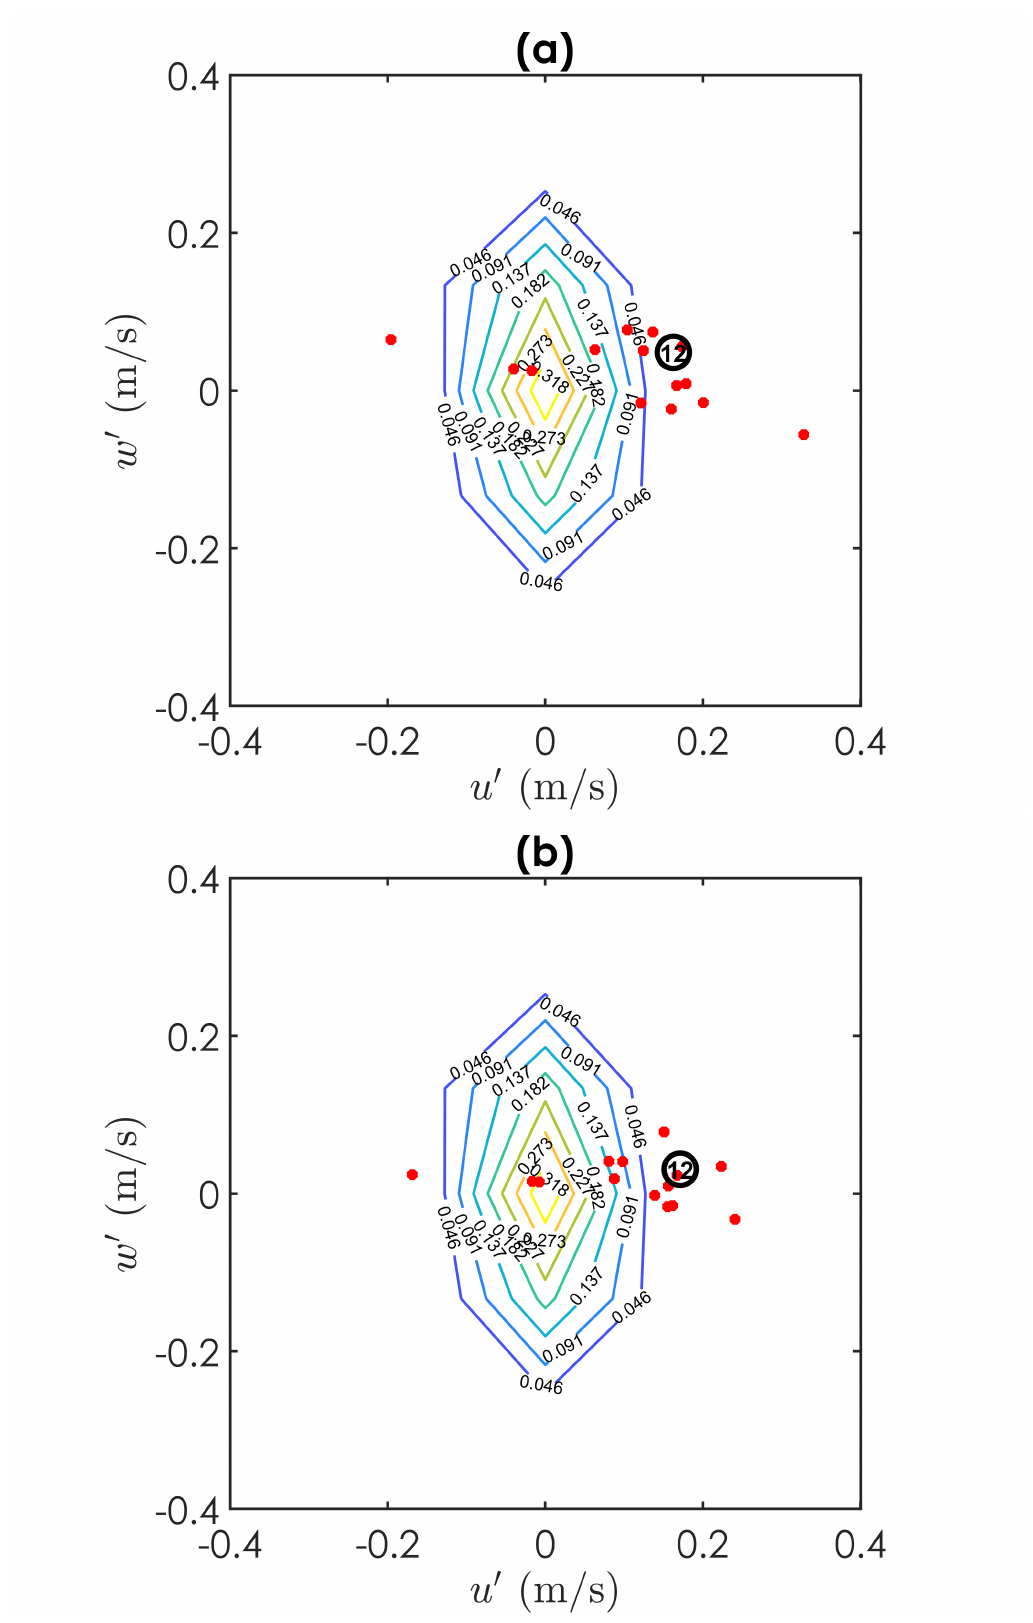
Figure 7. Reference velocity fluctuations (red dots) characterizing: ( a ) test T1-Approach A; ( b ) test T1-Approach B. Contour lines represent the 2D histogram of the velocity time fluctuations at the reference height for the entire set of PIV